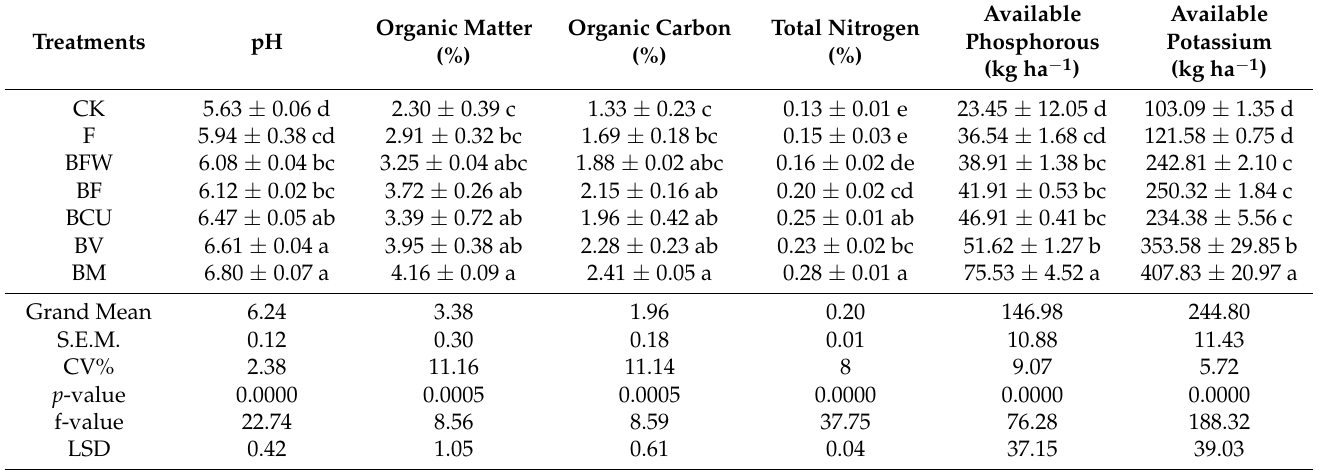
Table 4. Effect of biochar-blended organic and inorganic fertilizers on soil parameters. Values are means ± standard deviation, followed by the different letters in the column denoting significant difference at the 0.05 level using Tukey’s HSD test.